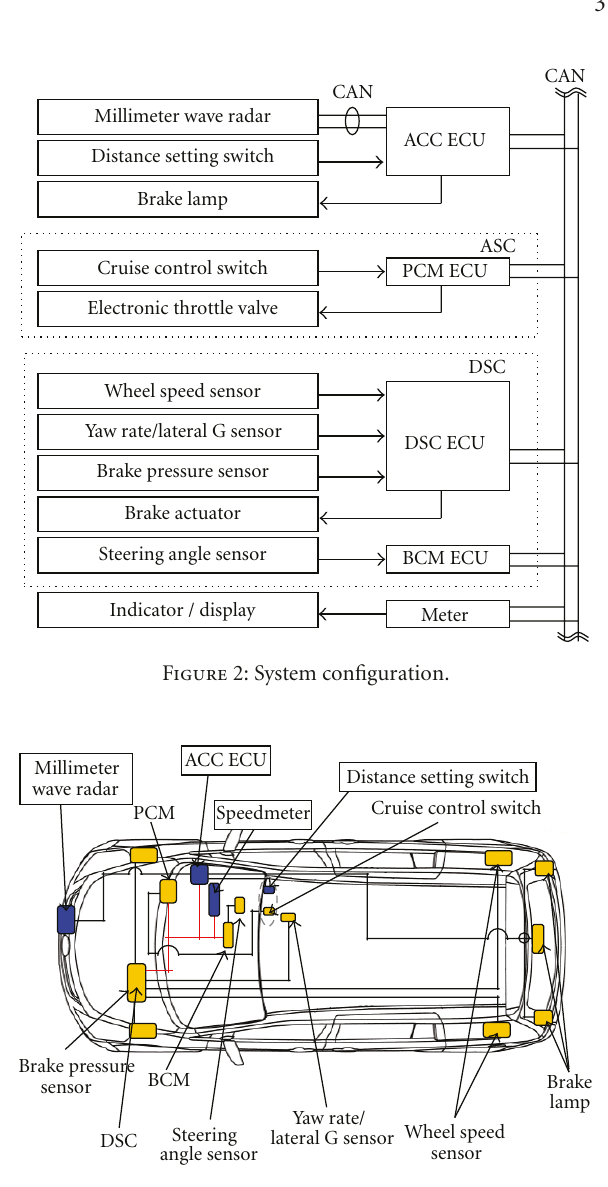
Figure 3: ACC unit